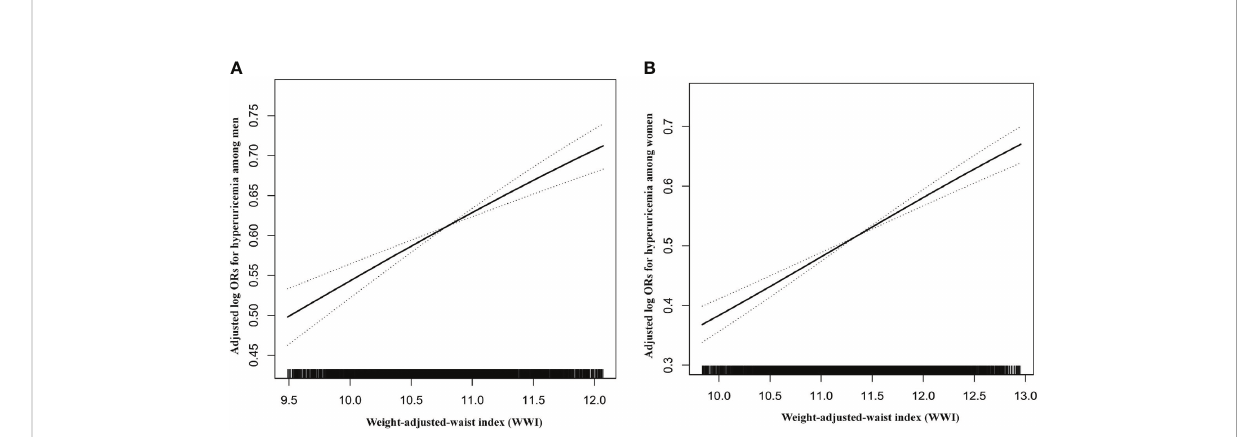
FIGURE 1 Dose – response relationship between WWI and hyperuricemia. (A) Men; (B) Women. All adjusted for age, heart rate, stroke, diabetes mellitus, coronary heart disease, current smoking, current drinking, antihypertensive drugs, lipid-lowering drugs, glucose-lowering drugs, homocysteine, serum total cholesterol, triglyceride, high density lipoprotein, low density lipoprotein, and